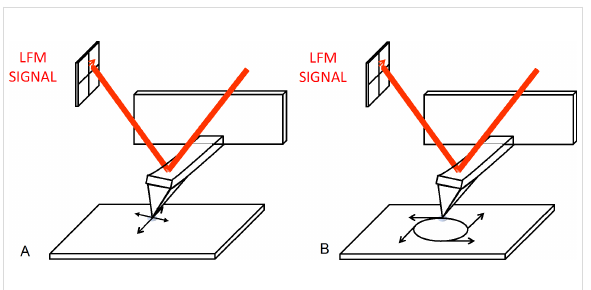
Figure 1: Schematic of the wear-induced atomic force microscopy (AFM) experimental protocols using (A) conventional scanning and (B) circular mode AFM circular